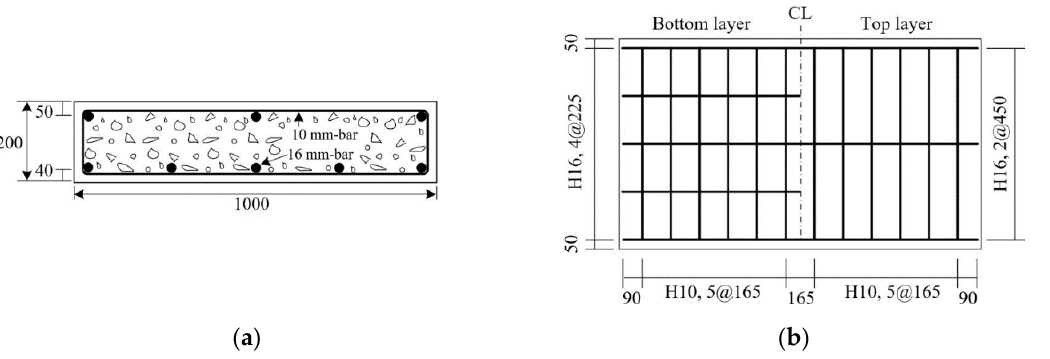
Figure 3. RC slab: ( a ) cross-sectional view; ( b ) reinforcement details (units: mm).